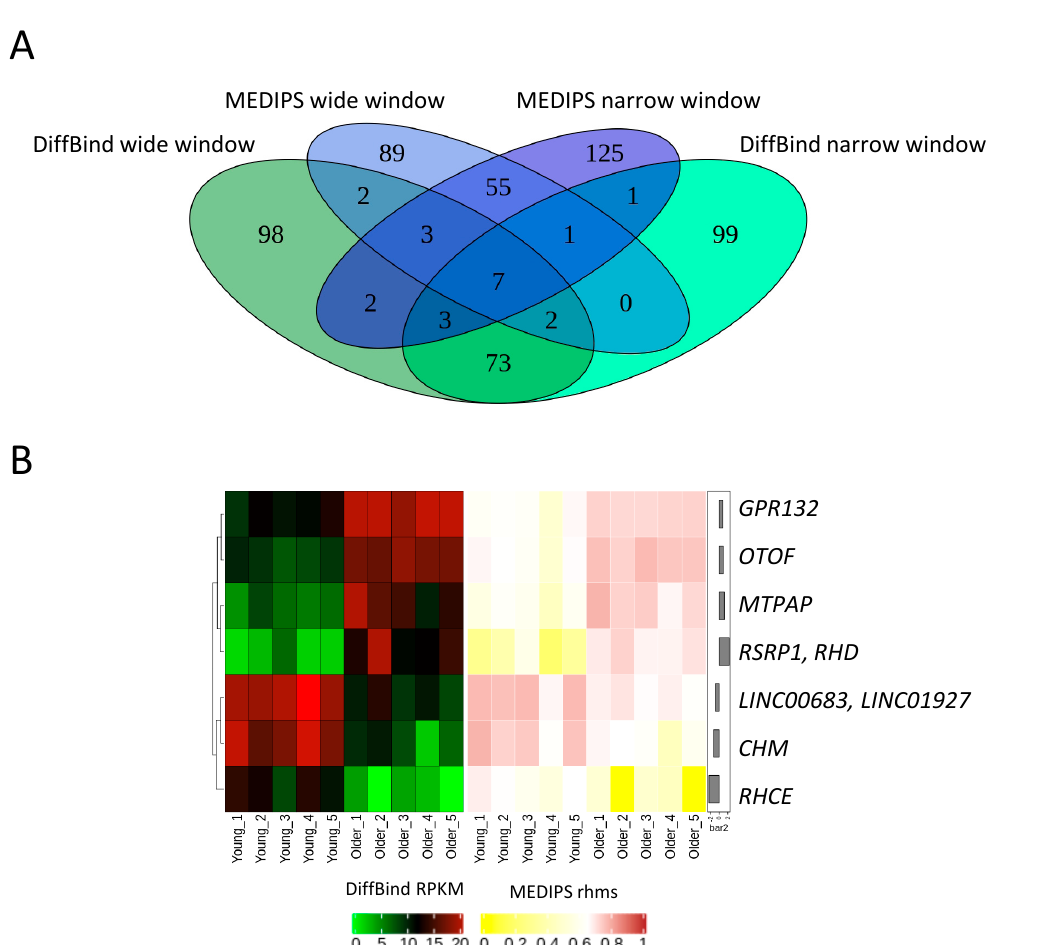
Figure 6. Age-associated differentially hydroxymethylated regions (DHMRs) in human fibroblasts common for all analyses. ( A ) Venn diagram of overlapping DHMRs. ( B ) Heatmap of overlapping DHMRs and their associated genes. RPKM: reads per kilobase million, rhms: relative hydroxymethylation score.